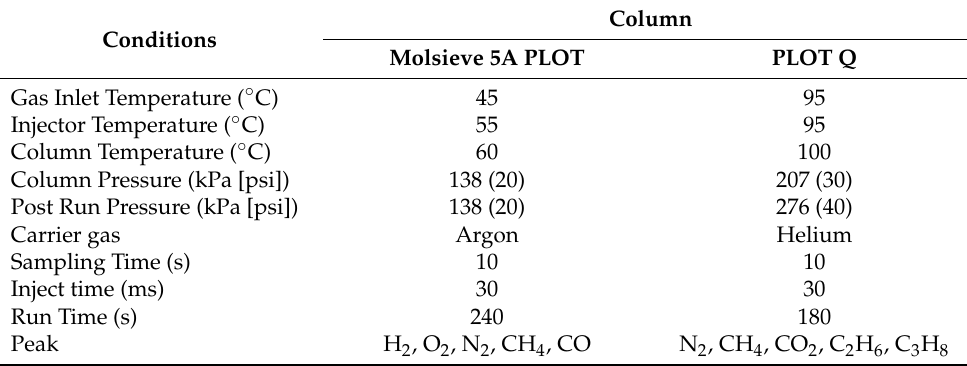
Table 4. The Gas Analysis Methods: The Analytical Conditions of Micro-GC.